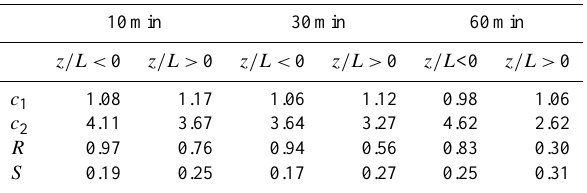
Table 2. Parameters of the fitting curve of MOS relation for vertical velocity